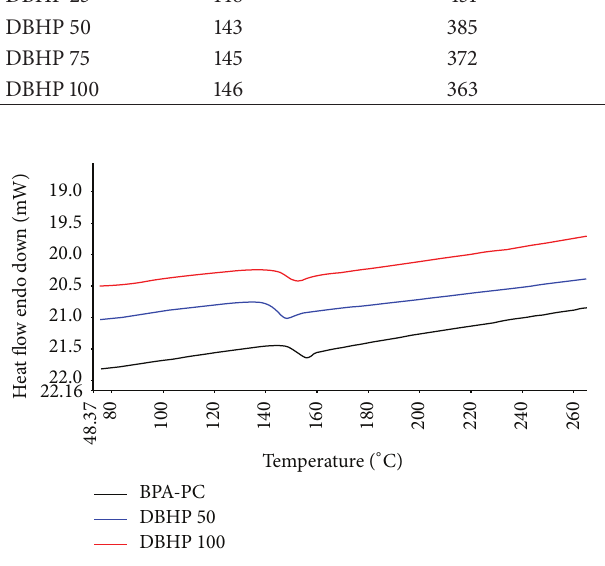
Figure 2: DSC of BPA-PC and DBHP-PCs.